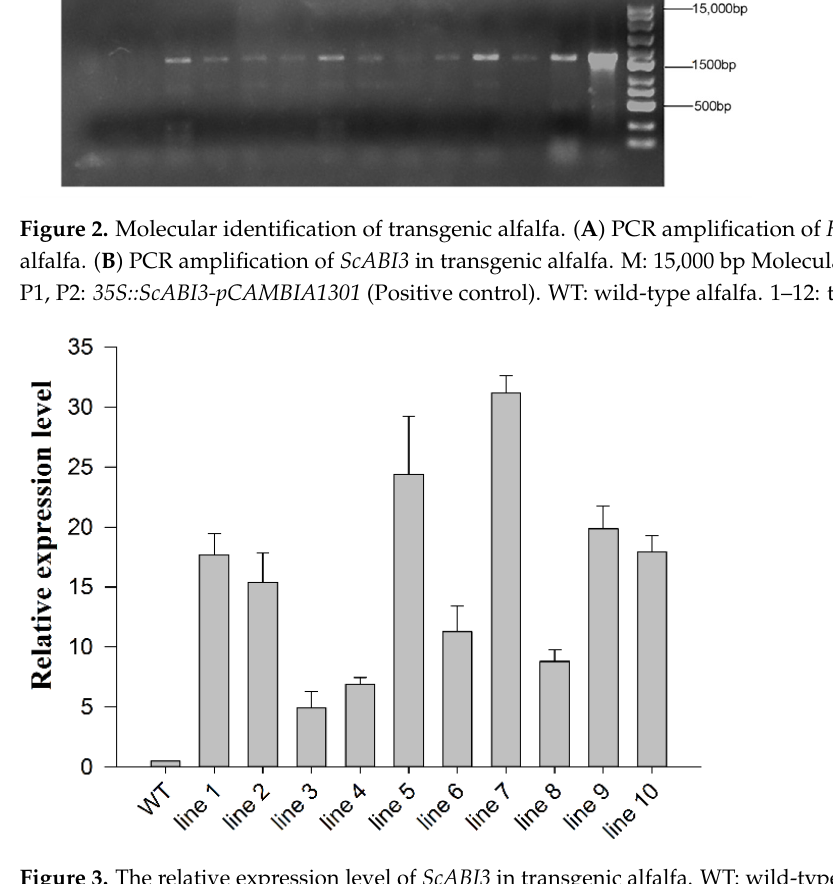
Figure 3. The relative expression level of ScABI3 in transgenic alfalfa. WT: wild-type alfalfa; line 1-10: transgenic alfalfa.